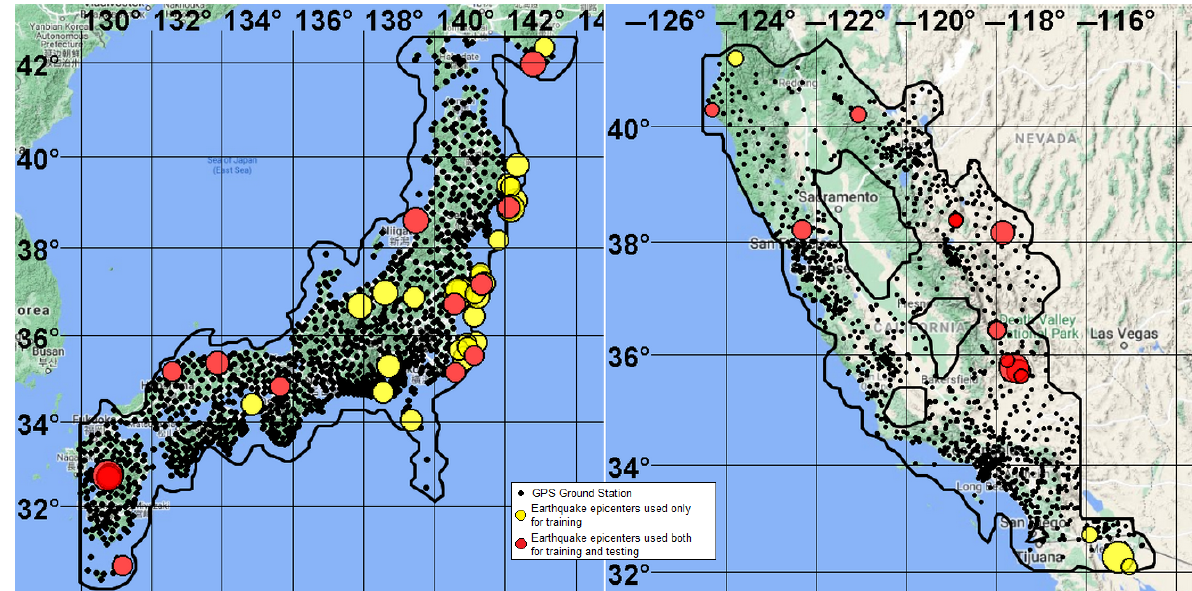
Figure 3. Areas of analysis, Global Positioning System (GPS) ground receiving stations, and the epicenters of target earthquakes. ( Left ) Japan, epicenters of target earthquakes with magnitude m ≥ 6.0 in the interval 1 January 2011–26 July 2020; ( Right ) California, epicenters of target earthquakes with magnitude m ≥ 5.5, in the interval 23 December 2009–14 November 2020. The epicenters of the target earthquakes for which the forecast was tested are highlighted in red and the epicenters on which the forecast was initial trained in